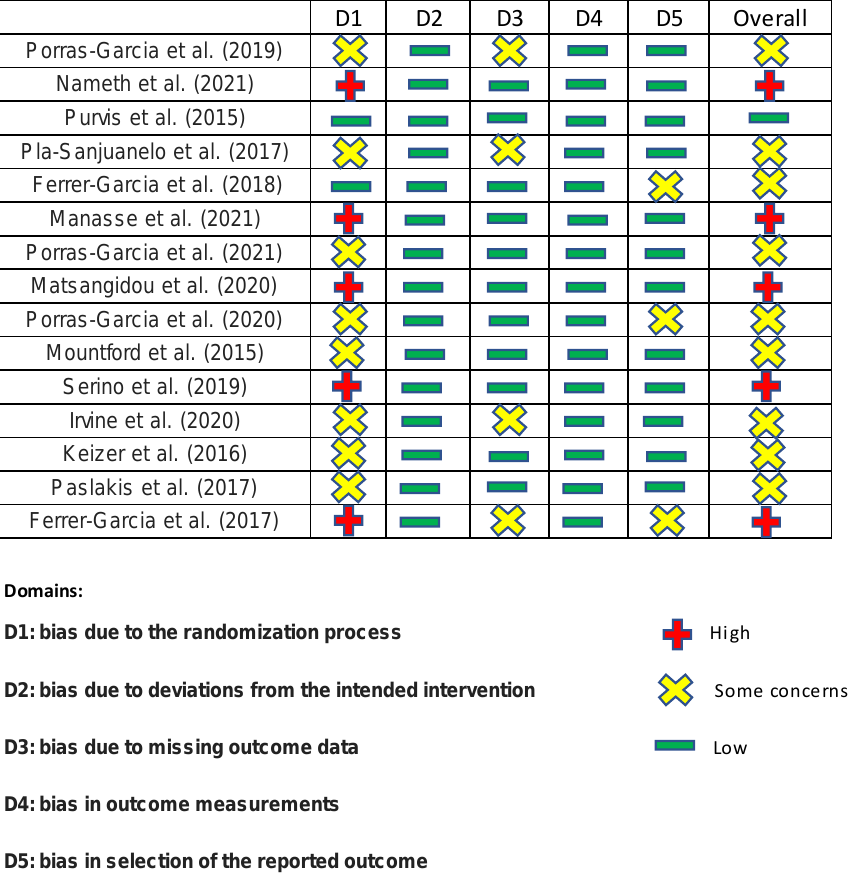
Figure 1. Risk of bias of all included papers [5–11,18–25].